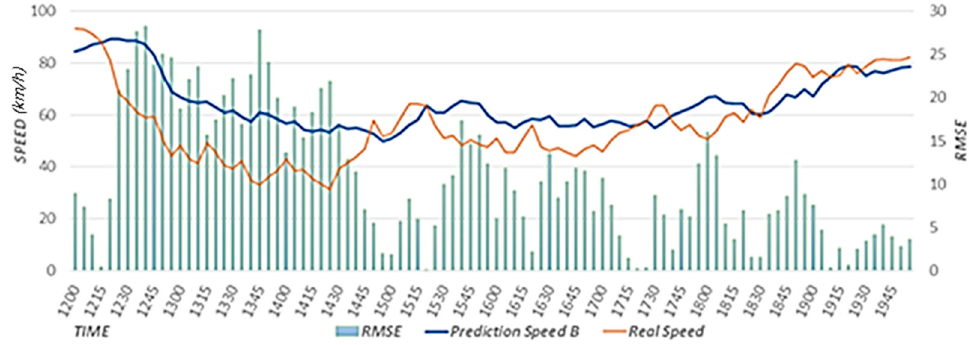
Figure 12. Speed predicted considering the effects of neighboring roads only.